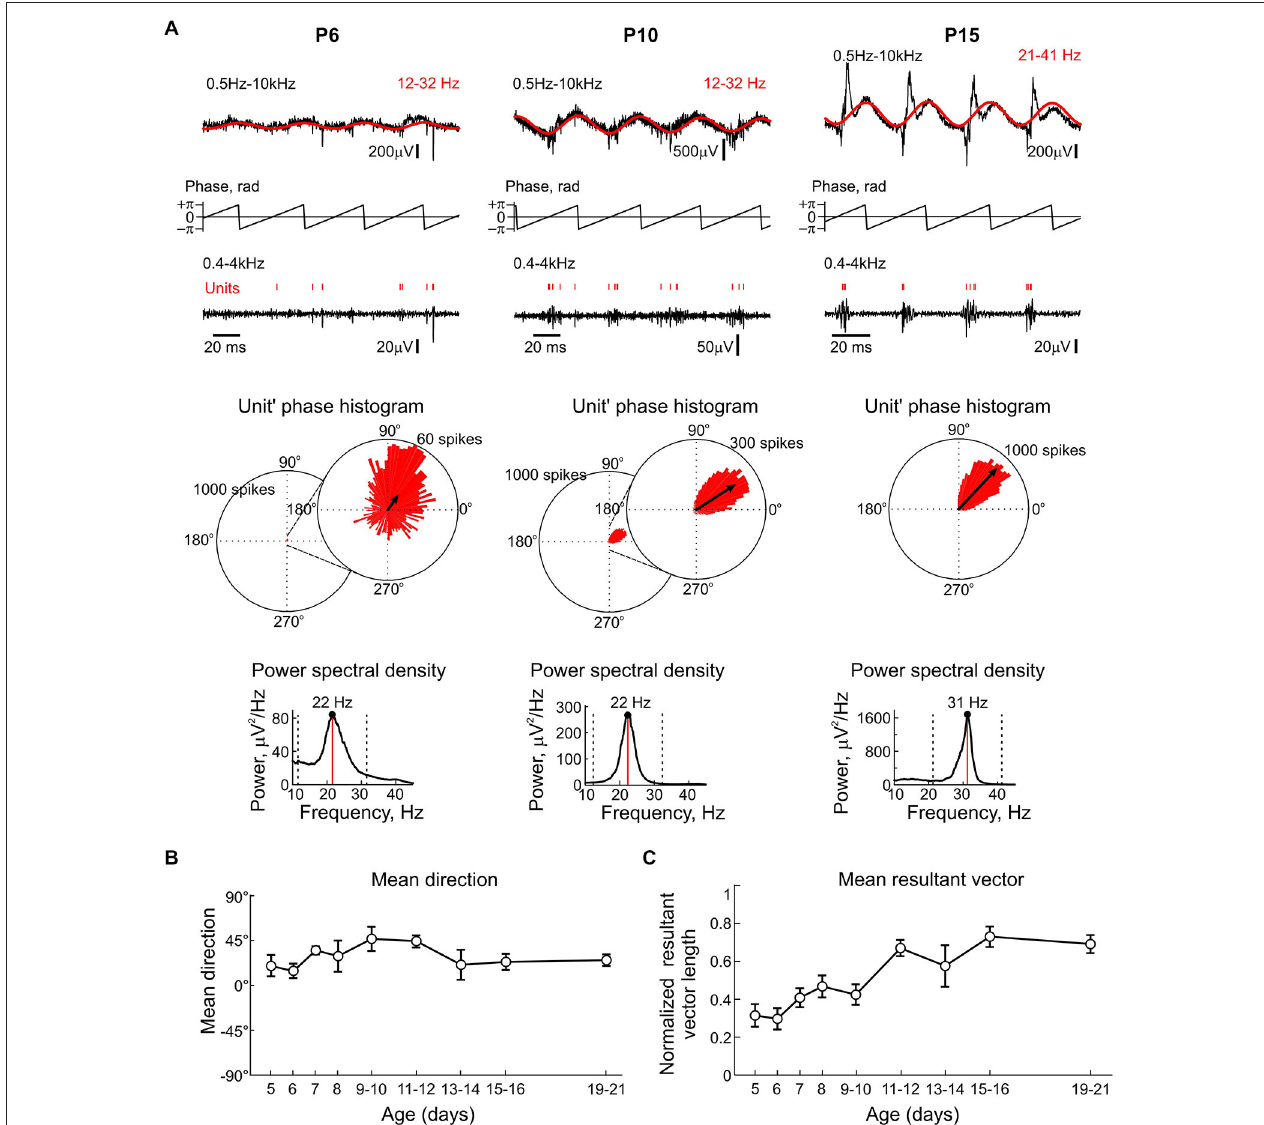
scale of 1000 spikes and rescaled histograms at 60 and 300 spikes at P6 and P10, respectively. Histograms were built from 1845, 6388, 17202 spikes recorded in P6, P10 and P15 rat slices, respectively during 100 s recording sessions. Corresponding LFP power spectral densities are shown on insets. (B,C) Summary plots of the age-dependence of the mean direction (B) and mean resultant vector amplitudes (C) . (B,C) Pooled data from n = 81 slices obtained from n = 37 P5–21